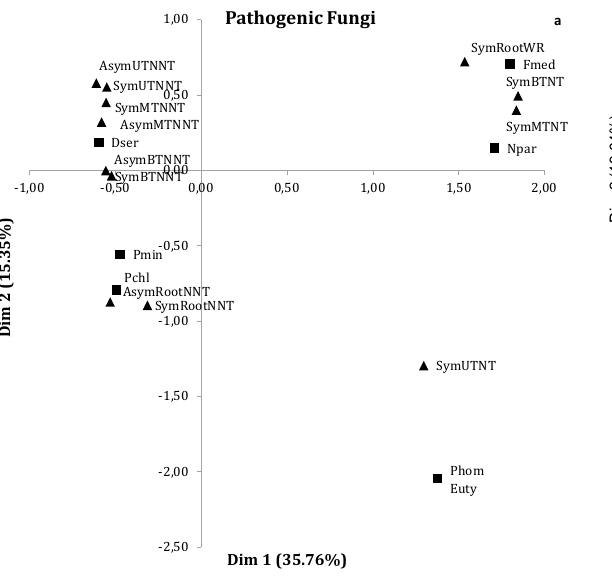
Figure 2. Plots resulting from the correspondence analyses on the fungi isolated from 30-year-old asymptomatic and symptomatic ‘Cabernet Sauvignon’ grapevines located in a vineyard in NE Spain. Results are shown in two comple- mentary views of the same bidimensional space; (a) fungi known to be associated with grapevine trunk diseases (squares), and (b) other fungal taxa (circles). Legends to individually separated types of vines (Sym, symptomatic; Asym, asymptomatic), plant parts (Root; BT, basal trunk; MT, medium trunk; UT, upper trunk) or tissue types (NNT, non-necrotic tissue; NT, necrotic tissue; WR, white rot) are shown in triangles. Abbreviation of fungal species associ- ated to grapevine trunk diseases are: Dser, Diplodia seriata ; Npar, Neofusicoccum parvum ; Euty, Eutypa cf. lata ; Fmed, Fomitiporia mediterranea ; Pchl, Phaeomoniella chlamydos- pora ; Pmin, Phaeoacremonium minimum ; Phom, Phomopsis sp. Codes for other isolated taxa isolated are: 1, Paraconio- thyrium brasiliense ; 2, Paraconiothyrium variabile ; 3, Acremo-